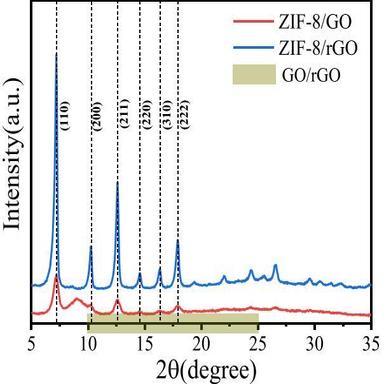
XRD spectra of ZIF-8/rGO and ZIF-8/GO composites.